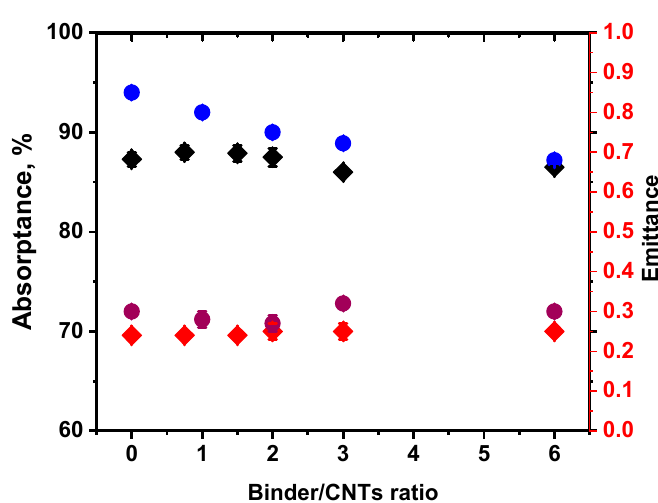
Figure 2. The absorptance and emittance of coatings made of various CNT concentrations, prepared with and without binder composed of boehmite (AlOOH) and polysiloxane (MTMS) with a ratio of 2:1. The binder/CNT weight ratio was 8.4:1 ( ◆ —without binders, █ —with binders).